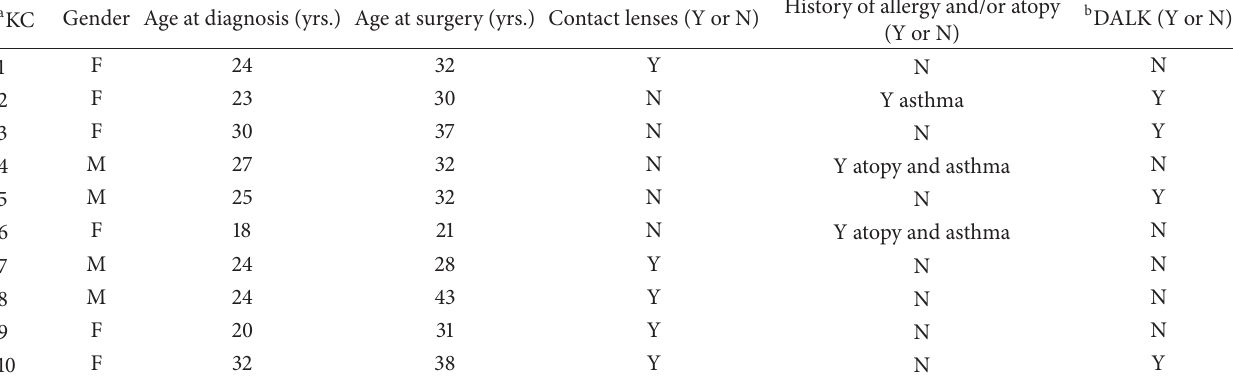
Table 1: Characteristics of KC